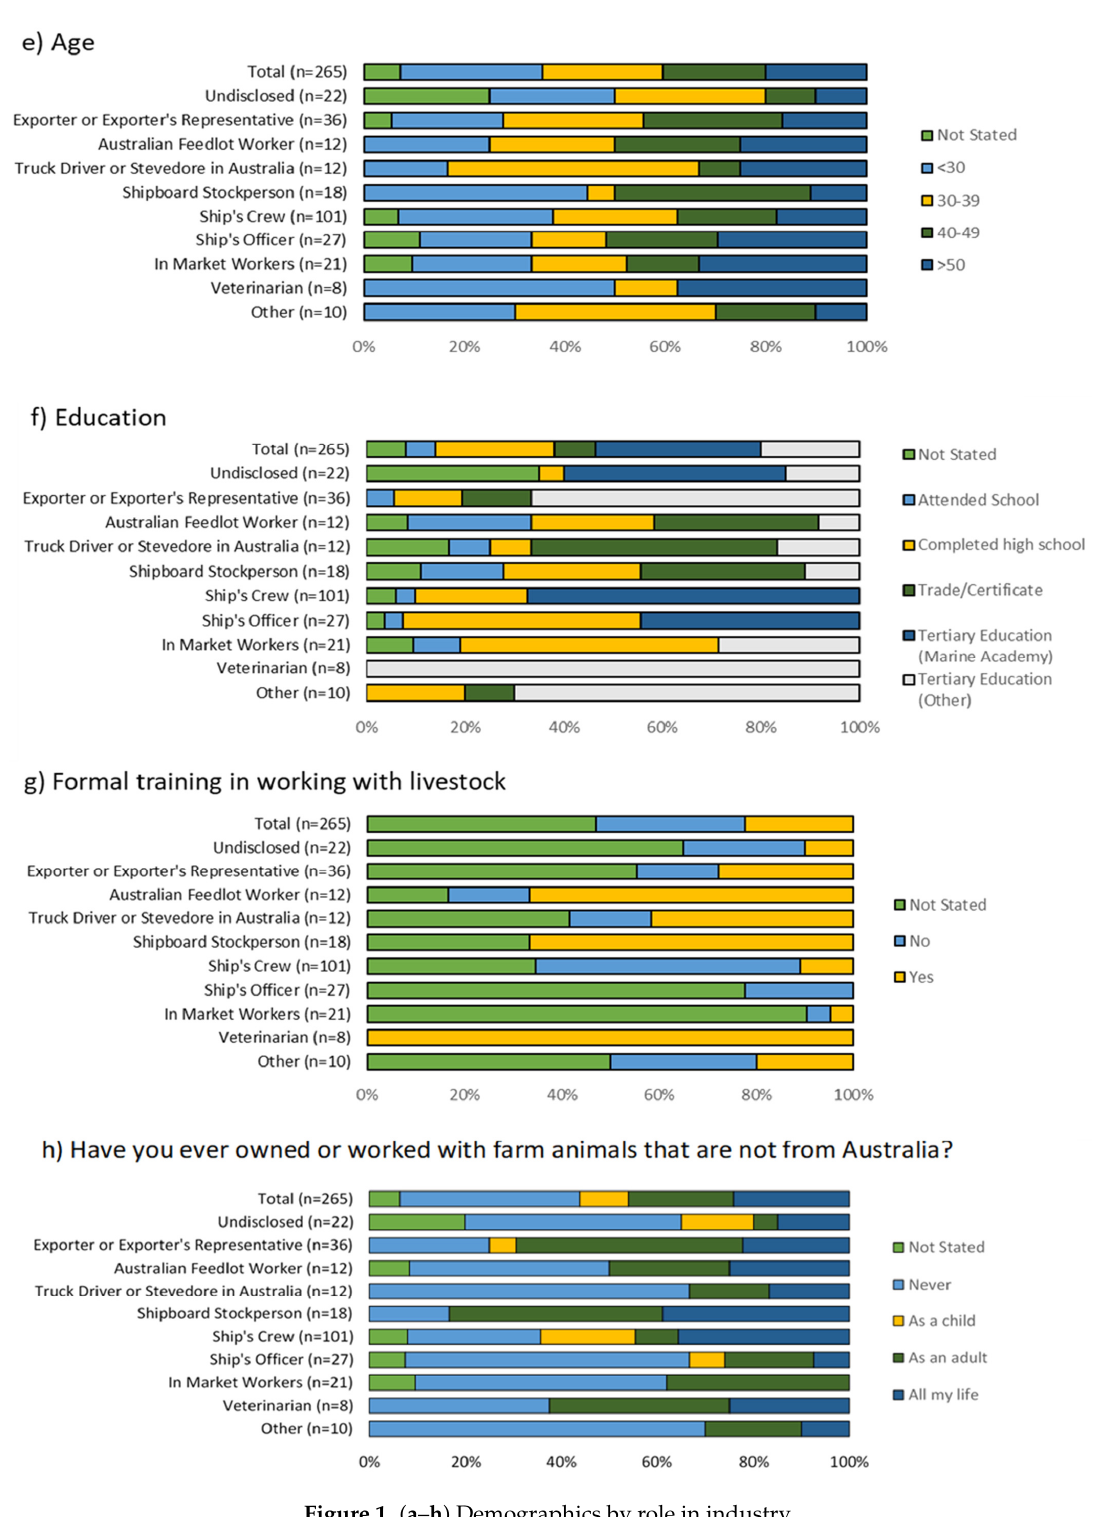
Figure 1. ( a – h ) Demographics by role in